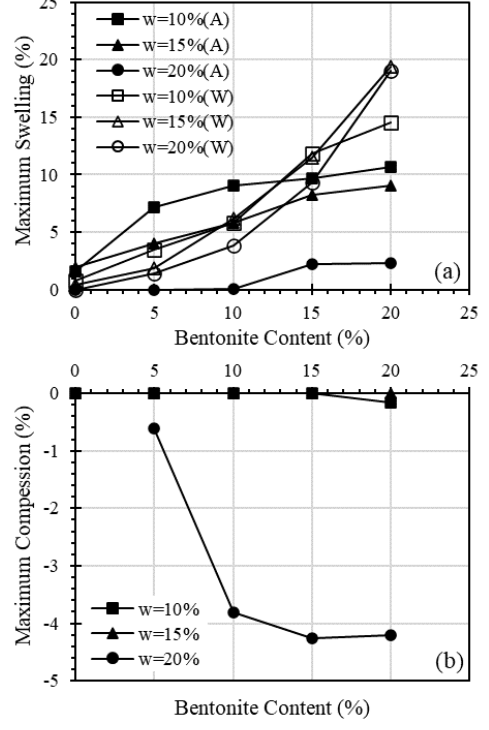
Fig. 5. (a) Maximum swelling and (b) maximum compression as a function bentonite